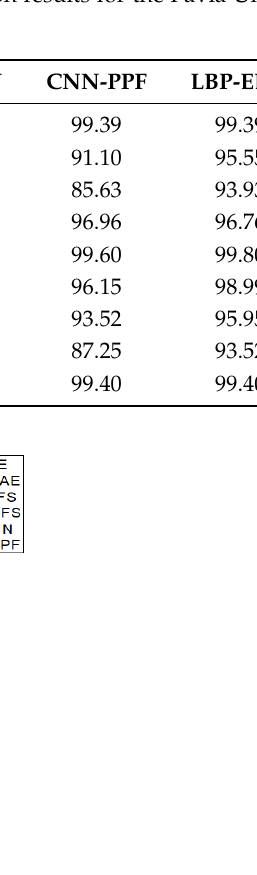
Figure 12. Different methods of various types of accuracy comparison results for the Pavia University